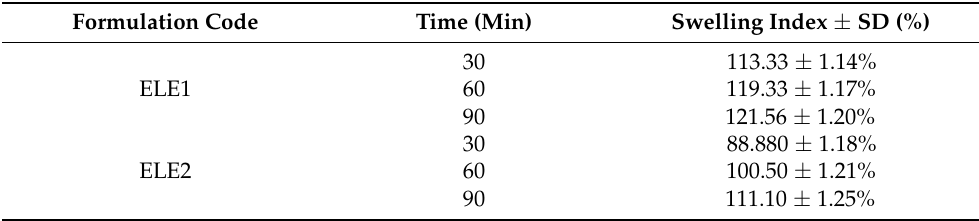
Table 4. Swelling index of blank (ELE1) and drug-loaded (ELE2) formulations.